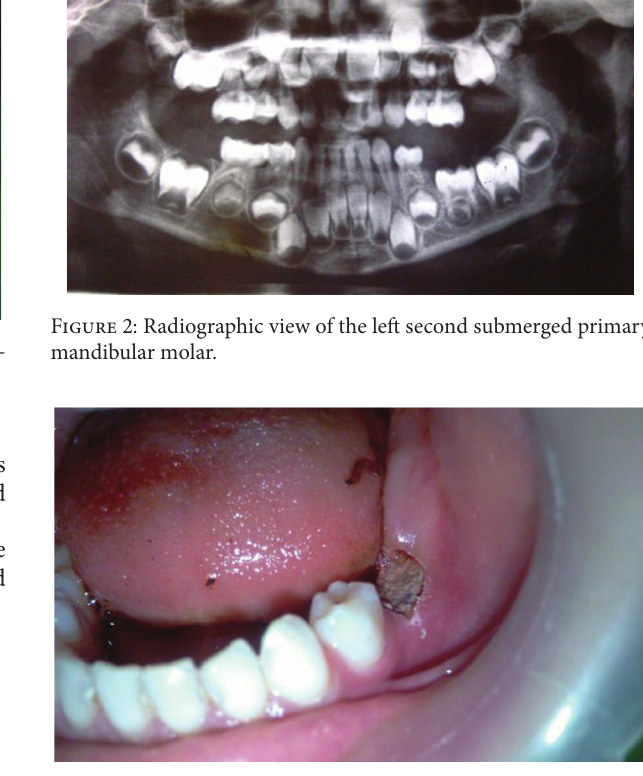
Figure 3: The surgical site was packed with reinforced zinc oxide eugenol.